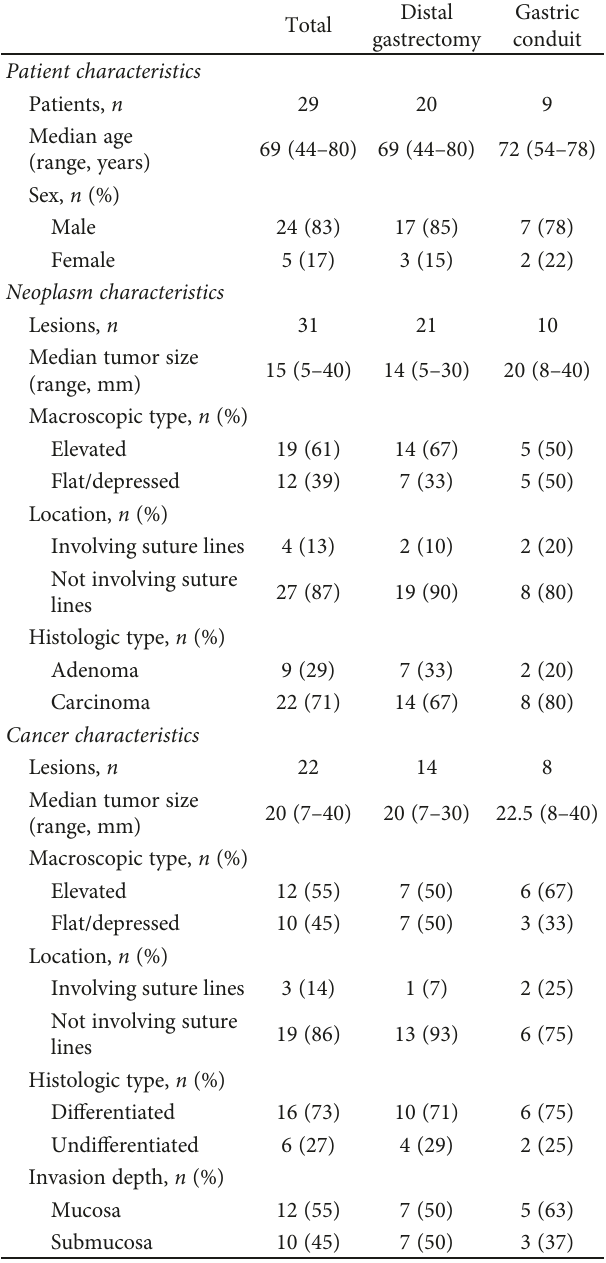
Table 1: Clinicopathologic characteristics of patients with gastric epithelial neoplasms in the remnant